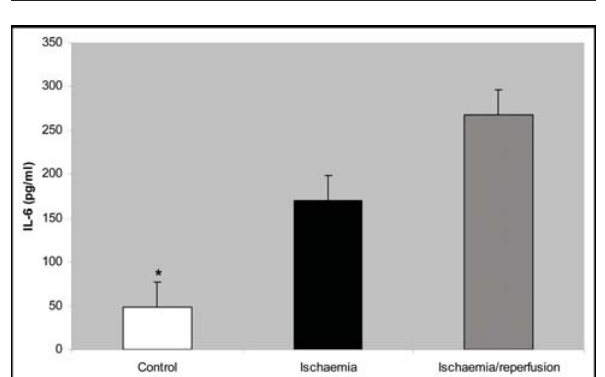
FIGURE 1 - Serum IL-6 in the three groups. Data represent the mean and the SEM. *, p=0.02 versus ischemia group, and p<0.001 versus ischemia/ reperfusion